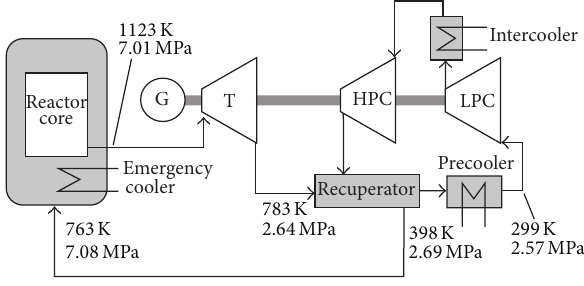
Figure 1: Flow diagram of the GT-MHR [14].